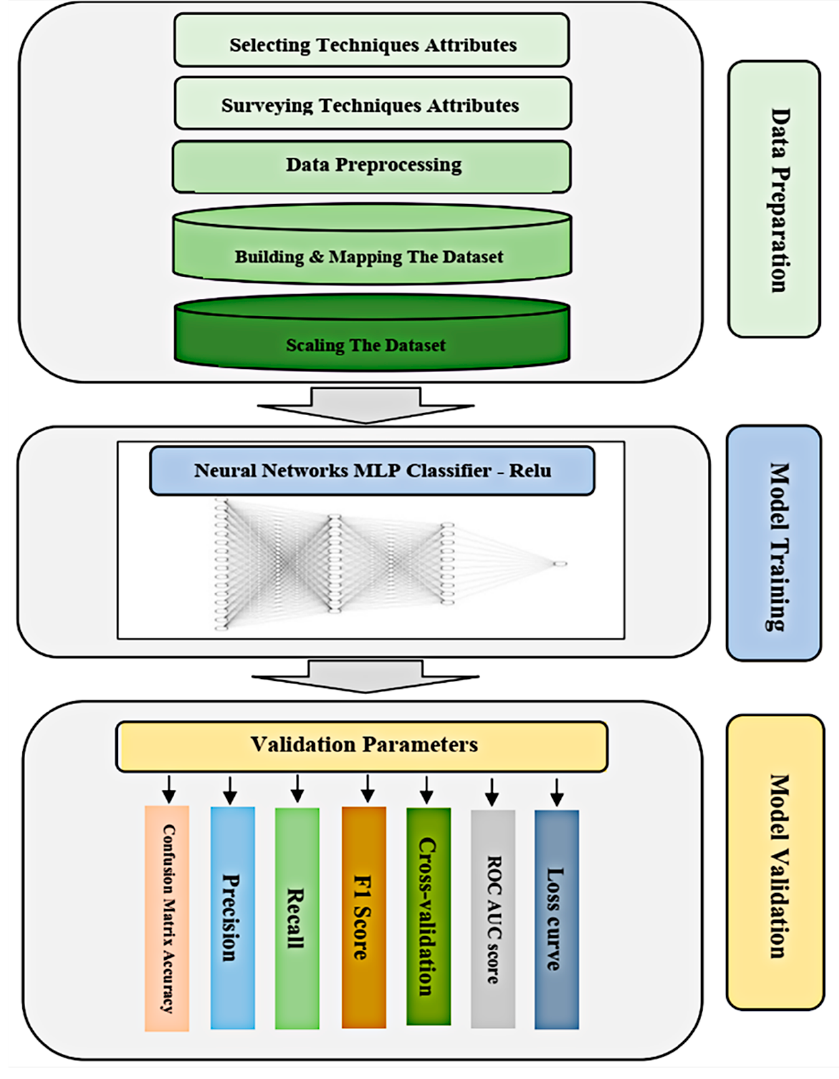
Figure 1. Methodological flowchart.